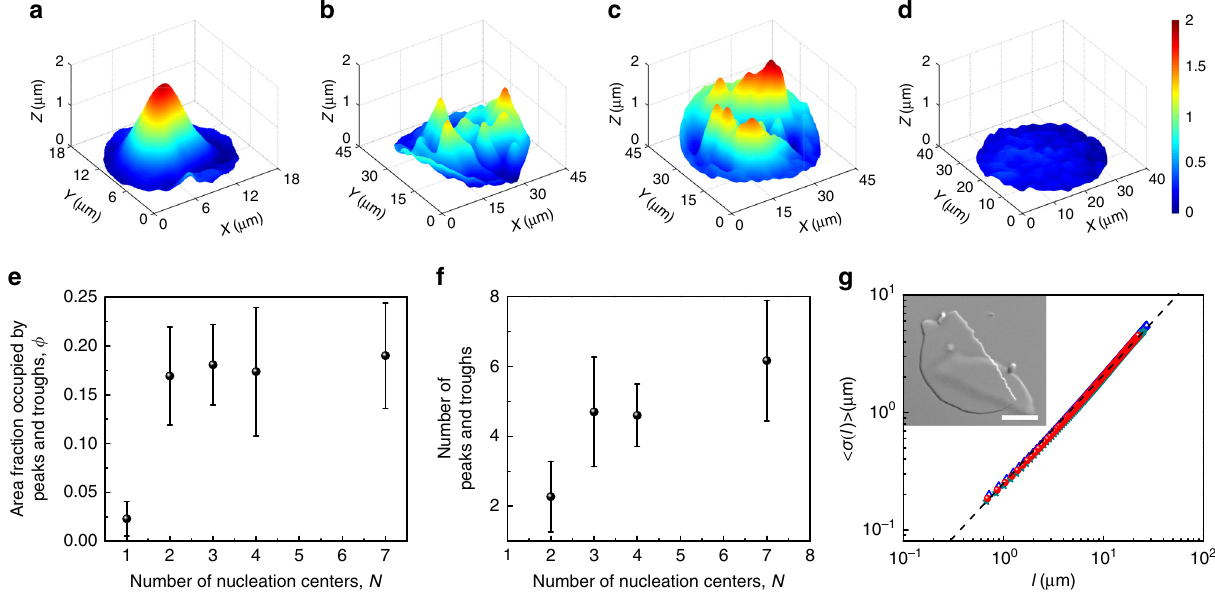
Fig. 4 Wrinkling and crack formation in crystalline colloidal membranes. 3D rendered confocal images of crystalline colloidal membranes formed out of chiral fl uid membranes containing a two, b three, c four nucleation centers. d 3D rendered confocal image of crystalline colloidal membrane formed out of nearly achiral fl uid colloidal membrane containing seven or more nucleation centers. All panels have the same color code for z -axis values as shown in the sidebar of d . e ϕ , area fraction of crystalline membranes covered by peaks and valleys, as a function of number of nucleation centers. The error bars correspond to the standard deviation of ϕ . f The number of peaks and troughs within crystalline membranes as a function of number of nucleation centers for membranes formed out of more than one nucleation center. The error bars correspond to the standard deviation of the number of peaks and troughs. g Standard deviation of cracked edge pro fi le σ l ð Þh i as a function of box length l for three different crystalline colloidal membranes. Dashed line is a fi t to the data with a slope of 0.84. Inset shows DIC image of a cracked colloidal membrane. Scale bar, 10 μ